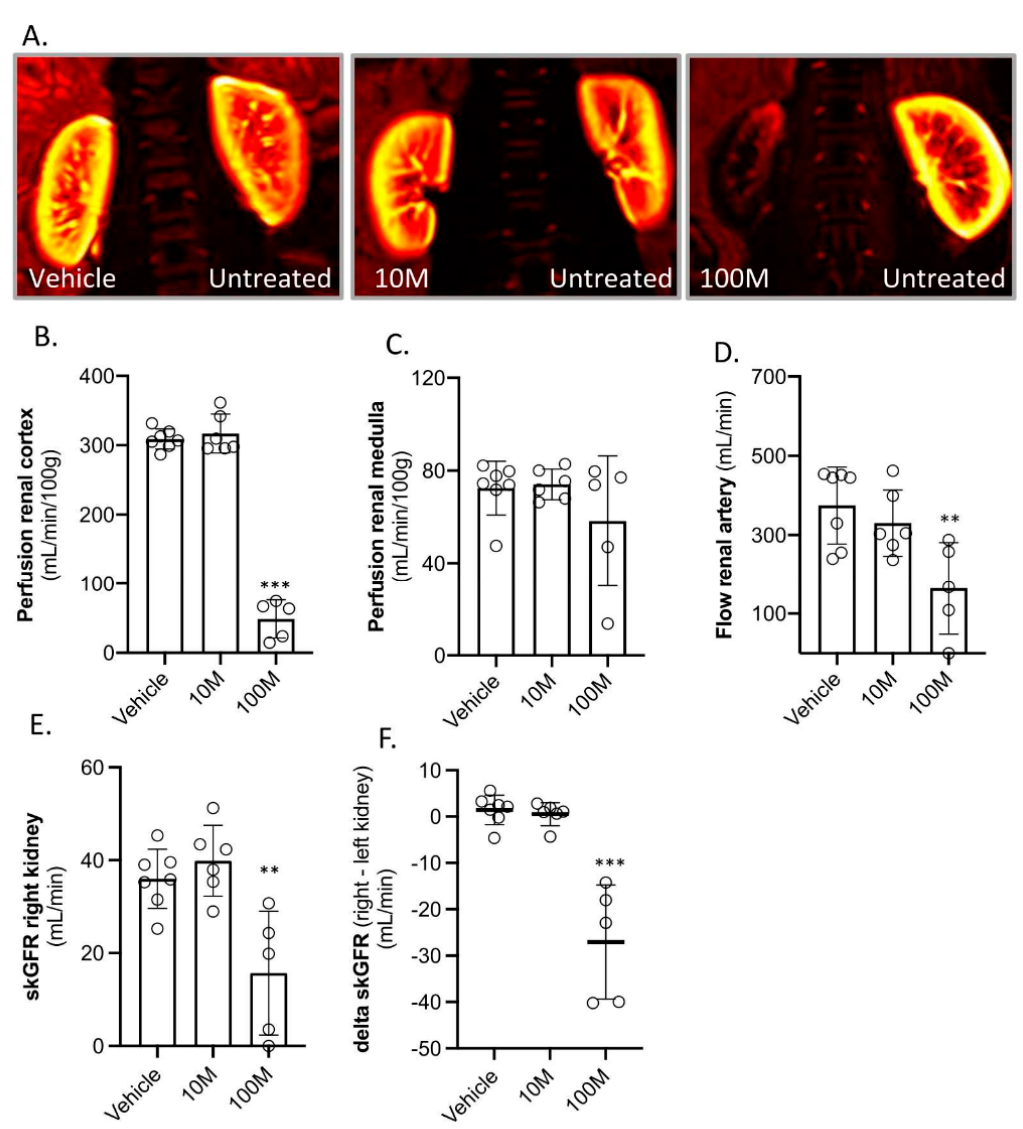
Figure 2. Kidney hemodynamics and plasma creatinine levels two weeks after intra-renal arte- rial MSC administration (right kidney). The animals were treated with vehicle (PBS; n = 7), ten million MSCs (10M; n = 6), and one hundred million MSCs (100M; n = 5). ( A ) Reconstructed 2D MRI images demonstrating renal perfusion. A representative picture of each group is shown. ( B – D ) Haemodynamics parameters quantified by MRI of the treated kidneys. ( E ) Single kidney GFR (skGFR) of the treated kidney measured two weeks after treatment. ( F ) Difference in skGFR between the treated (right kidney) and non-treated kidney (left kidney). *** p < 0.001, ** p < 0.01 vs. the vehicle group. skGFR was measured by urinary clearance of chromium-51 labelled EDTA. Graphs present the individual values, with the mean and standard